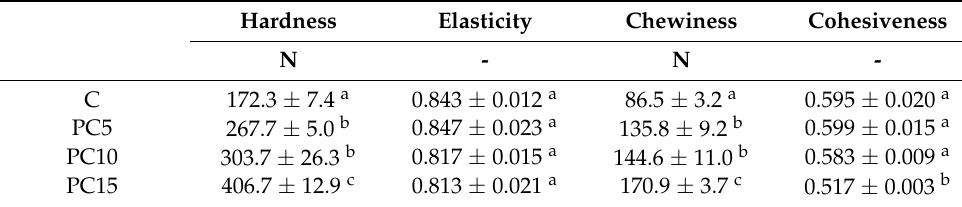
Table 4. Texture profile analysis of oatmeal cookies with poppy seed expeller added ( n = 10). Hardness Elasticity